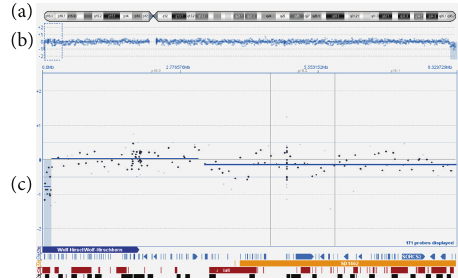
Figure 4: Array-CGH result of chromosome 4: 4p16.3 → pter deletion. There are three icons from top to down in total (a)– (c). (a) A diagram of chromosome 4. (b) A scatter plot of a copy number; each point represents the mean copy number calculated fromconsecutive100probesets.Thebaselineinthemiddleindicates the normal copy number level. Upward deviation from the baseline indicates amplification and downward departure from the baseline represents deletion. (c) Enlarged form of 4p16.3 → pter segment at (b) region; combed region represents copy number variants (CNV) that matches deleted